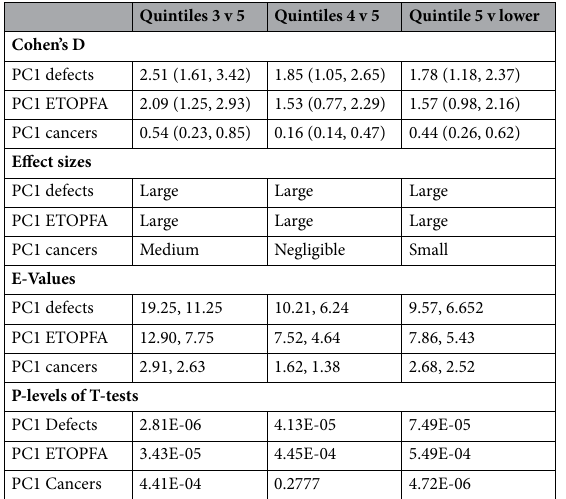
Table 1. Quintile analysis. Cohen’s D, Effect Sizes, E-Values and P-values for quintile analyses.